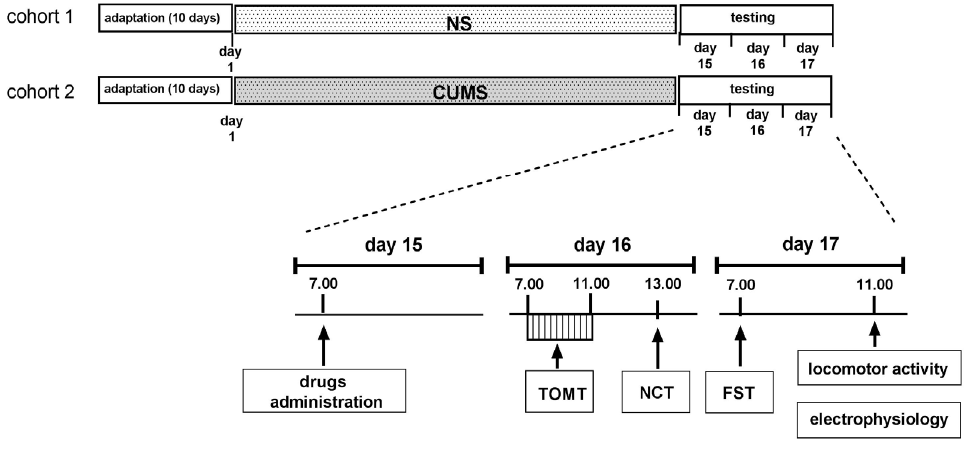
Figure 5. The schedule of the CUMS